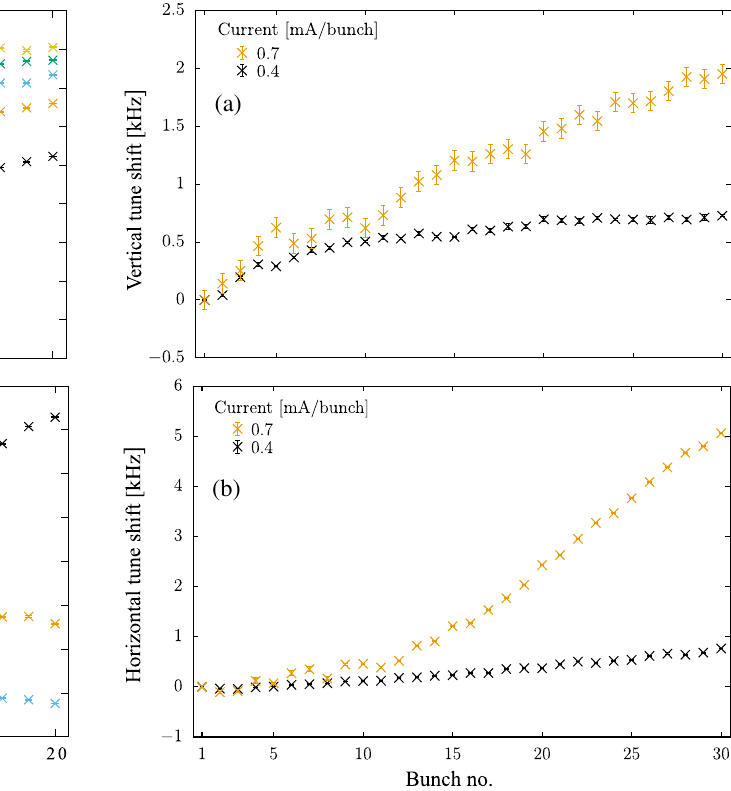
FIG. 2. Tune shifts measured in the (a) vertical and (b) hori- zontal planes using the tune tracker for a 20-bunch train of positrons with values for the bunch current ranging between 2 and 6 mA = bunch ( 3 . 2 – 9 . 6 × 10 10 bunch populations) at 5.3 GeV. Data were recorded separately for each of the two planes.